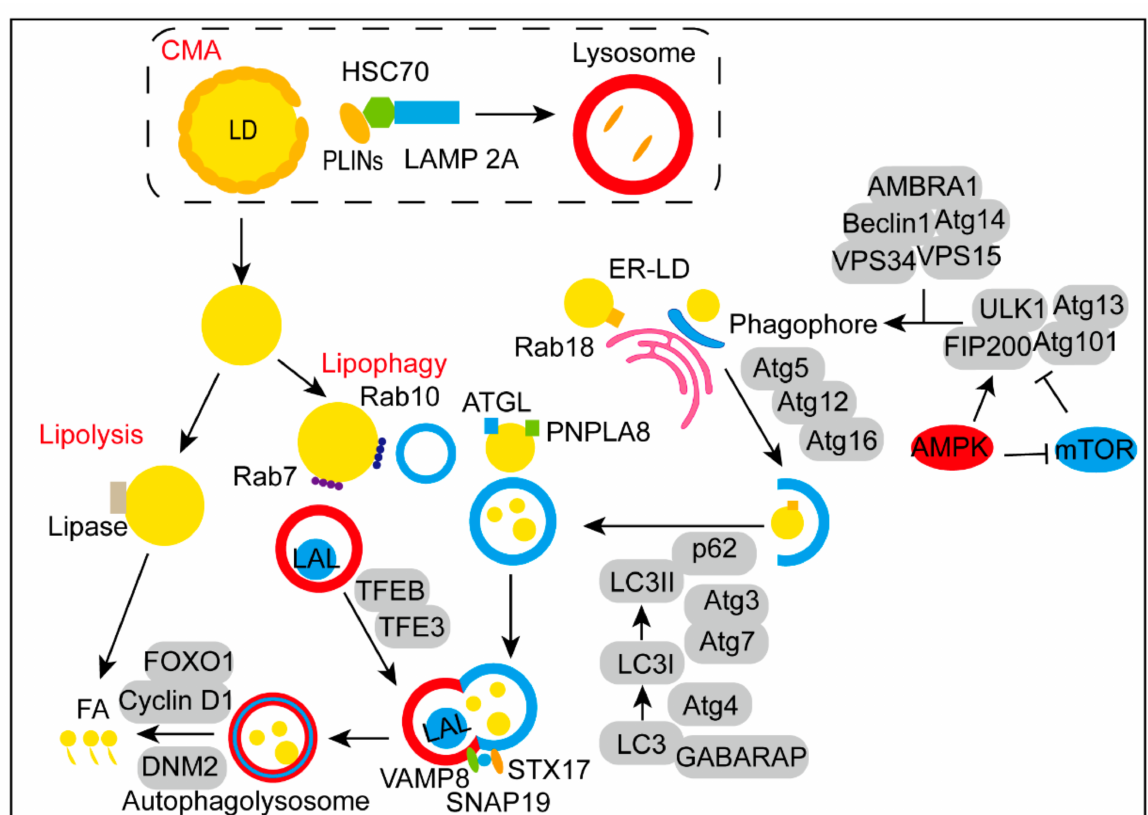
Figure 1. Steps of LDs degradation. After the degradation of PLIN2 and PLIN3 in lysosome via CMA mediated by HSC70, LDs are exposed for lipolysis and lipophagy. The activation of AMPK and mTOR recruits ULK1-Atg13-FIP200-Atg101 complex to trigger the initiation of autophagy. Next, the initiation complex composed of Beclin1, Atg14, VPS34, VPS15, and AMBRA1 is activated to form the origin of phagophore. Rab18 is essential in the spatiotemporal dynamic of ER-LD. During the elongation progress, the Atg5-Atg12-Atg16 complex promotes the autophagic vesicle formation. Simultaneously, Atg3, Atg4 and Atg7 are involved in the lipid-soluble form of LC3. Receptors such as p62 facilitate the localization of LC3-II on the autophagic membrane. On the surface of LDs, ATGL and PNPLA8 were identified as mammalian lipid receptors. Rab10 recruits LC3-positive phagophores to the circumference of LD, while Rab7 promotes the tethering and fusion of